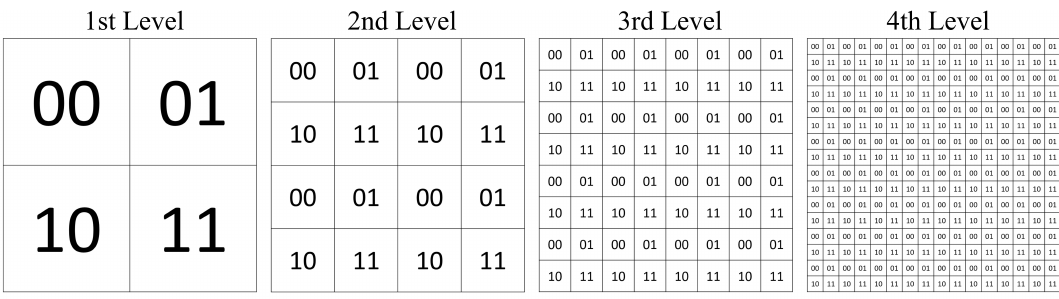
Figure 6. Example of labeling scheme for quarters at each level of decomposition.